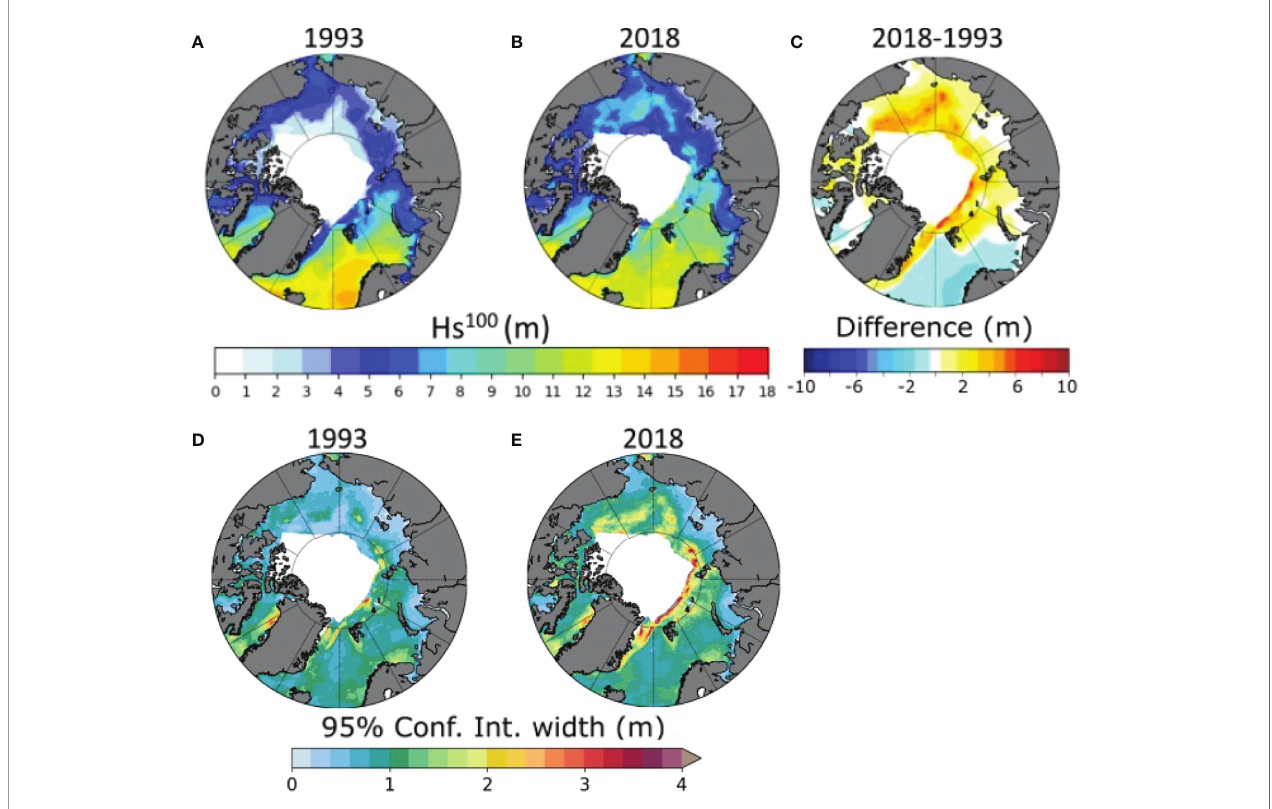
FIGURE 6 | H 100 s (m) obtained with a POT analysis (90 th percentile threshold) and a GPD distribution in the TS-EVA nonseasonal approach for (A) 1993 and (B) 2018. (C) The difference between estimations for 2018 and 1993. Width of 95% con fi dence interval for H 100 s for (D) 1993 and (E)